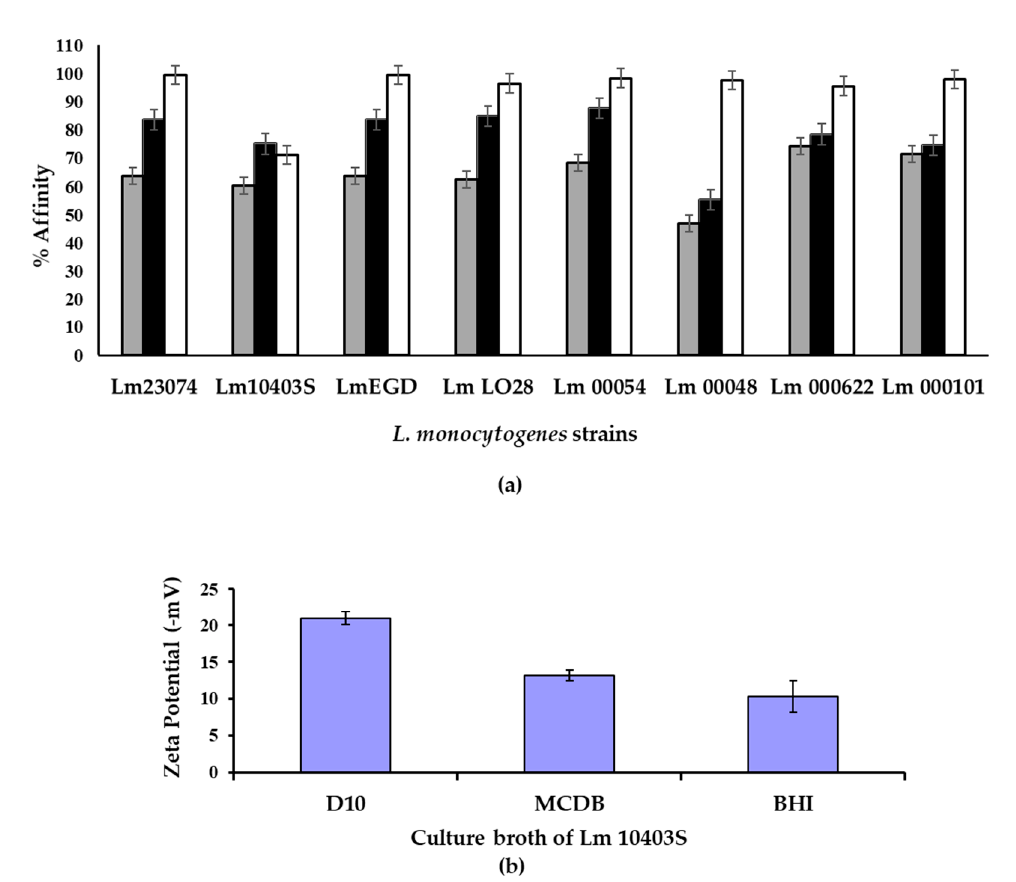
Figure 2. Representative cell hydrophobicity ( a ) assay showing affinity to chloroform solvent (500 µL) and zeta potential measurements ( b ) of strain Lm 10403S cells. Cells ( a ) were grown in MCDB 202 ( □ ), D10 ( ■ ) and BHI ( ■ ) media before an affinity analysis was carried out with the microbial attachment to hydrocarbon (MATH) method. The zeta potential ( b ) was measured and the results represent values from triplicate independent samples. Error bars represent two standard errors in both panels. Statistical modelling showed that the solvent type and volume, media and strain interaction were significant terms ( p < 0.05).